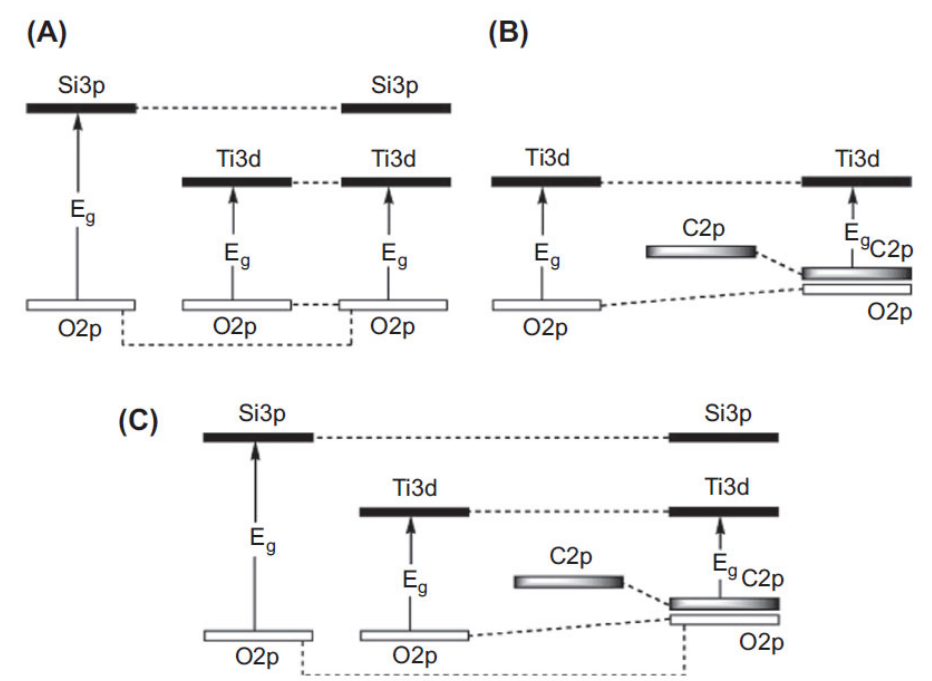
Figure 2. Simplified representation of hybridization of C2p and O2p orbitals and the formation of new valance bands, which reduce the bandgap. ( A )TiO 2 /SiO 2 , ( B ) graphene ‐ based NeTiO 2 , and ( C ) graphene ‐ based NeTiO 2 /SiO 2 composites. Figure use with permission from [97].